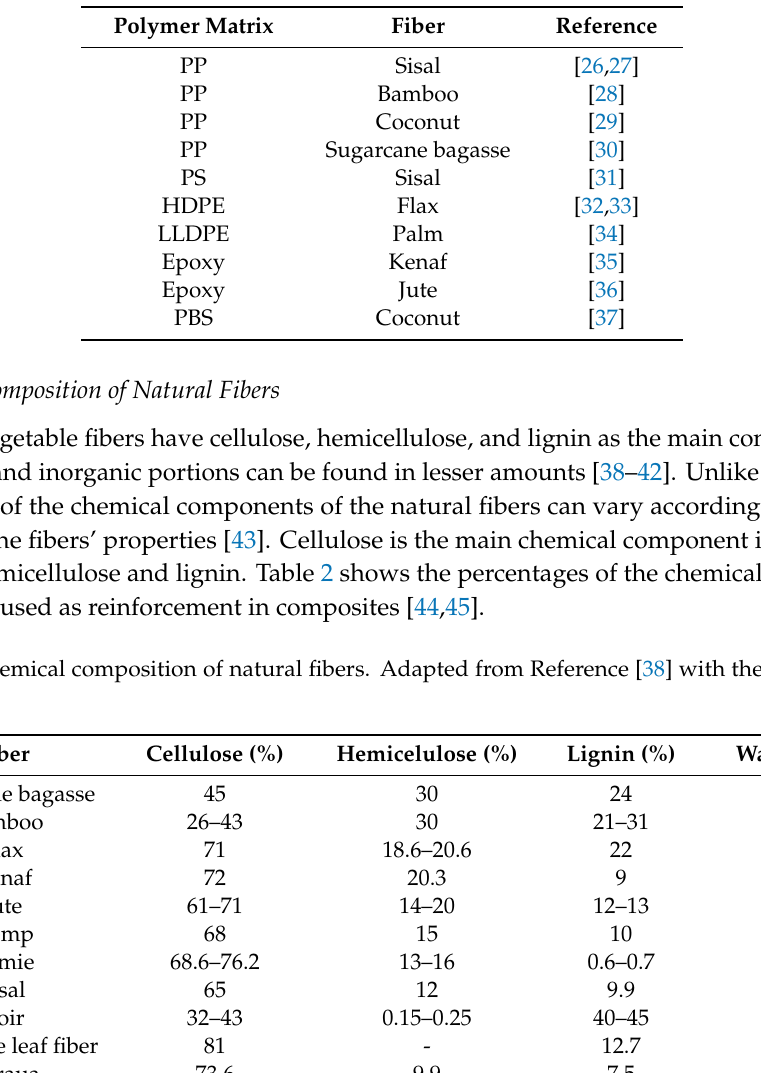
Table 1. Main fibers used as reinforcement and their respective polymer matrices.